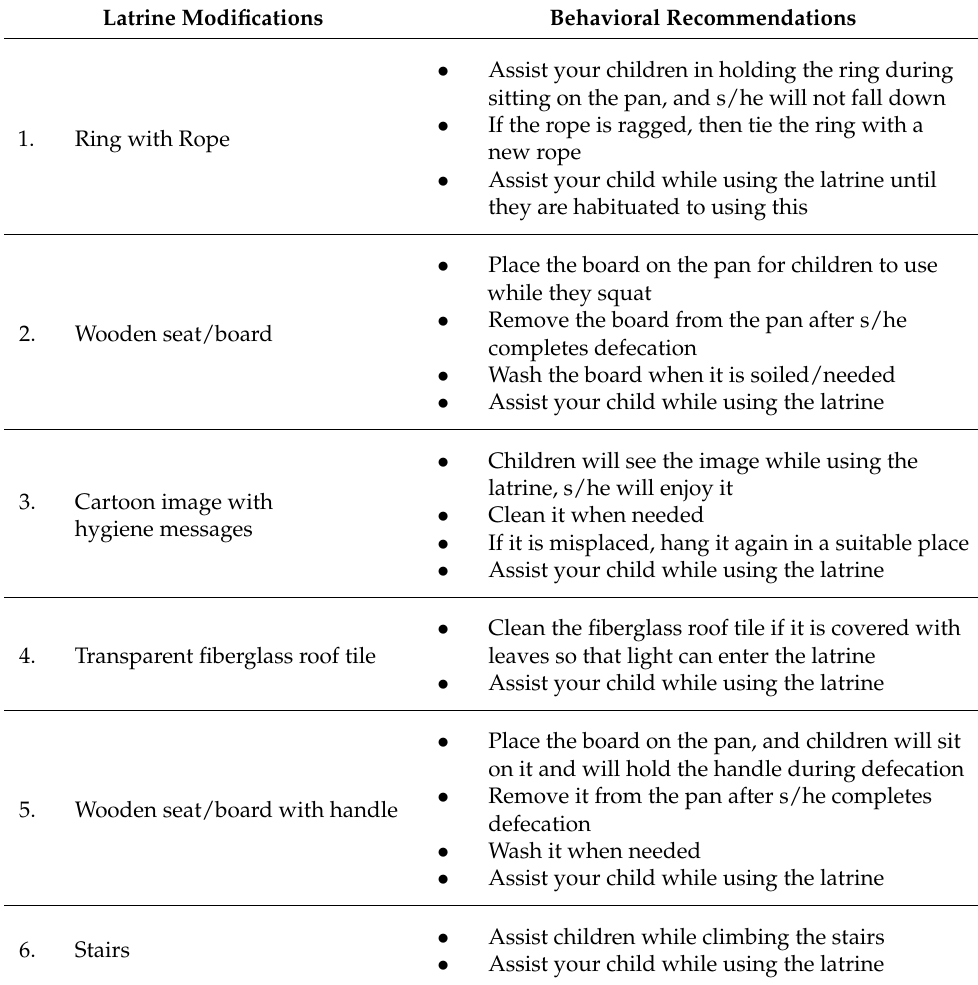
Table 3. Accompanying behavioral recommendations for each of the latrine